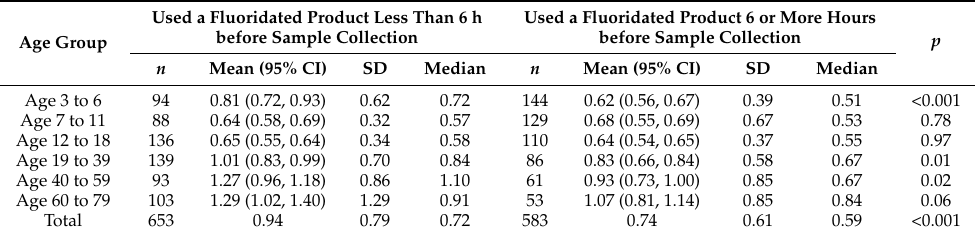
Table 2. T -tests comparing UF SG for individuals who have and have not used a fluoridated product recently, by age group. Used a Fluoridated Product Less Than 6 h before Sample Age Group